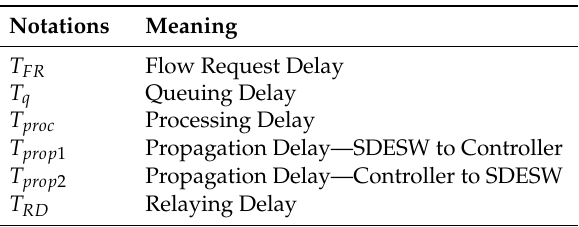
Table 2. Notations and